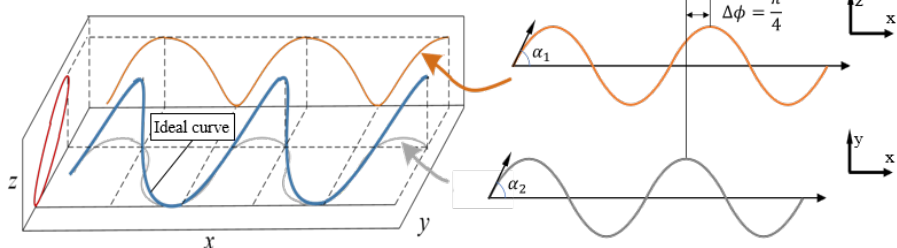
Figure 6. Target Configuration Curve of Sidewinding Gait. The target configuration curve can be seen as the spatial superposition of serpenoid curves in the horizontal and vertical directions, and the phase difference between them is π /4.